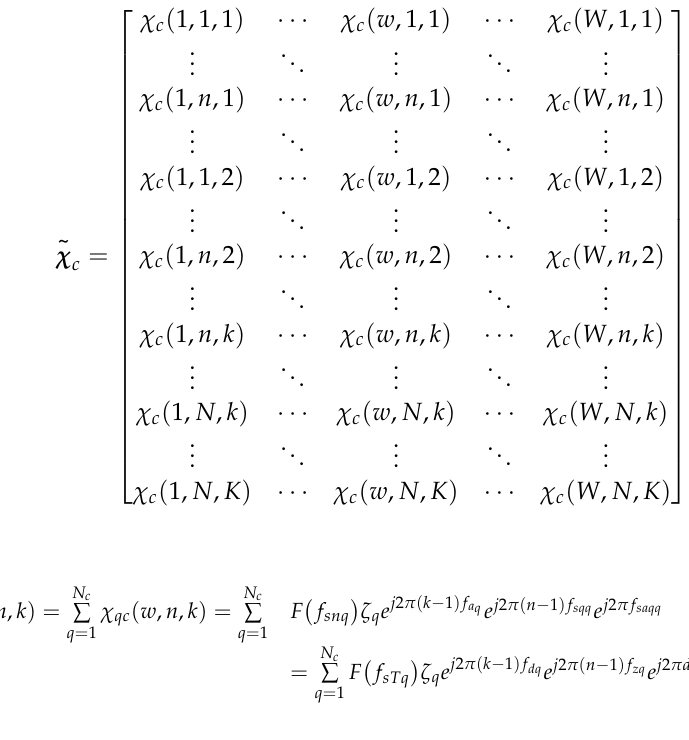
Figure 4. Schematic diagram for obtaining multi-frame echo data with equivalent reconstruction. The echo data of CUT are composed of the clutter data, target data, and noise data.